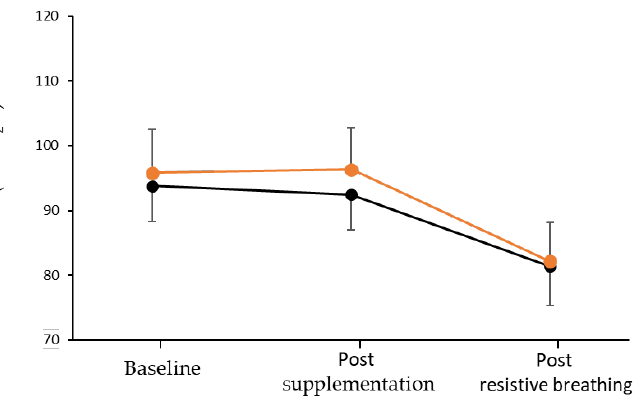
Figure 3. Maximal inspiratory pressure (MIP) at baseline, after seven days of L-citrulline (orange circles) and placebo (black circles) supplementation and post resistive breathing to task failure.